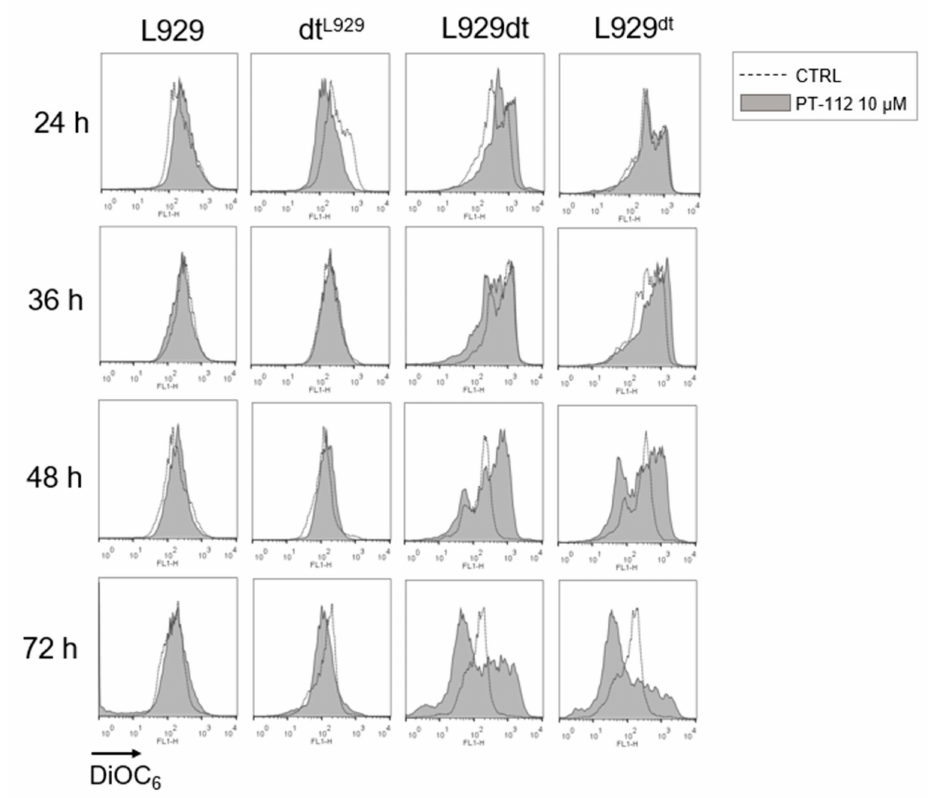
Figure 5. Analysis of mitochondrial membrane potential ( ∆Ψ m) upon treatment with PT-112 at different incubation times. A total of 3 × 10 4 cells were incubated with 10 µ M of PT-112 for 24, 36, 48 and 72 h at 37 ◦ C. Changes in ∆Ψ m were determined by staining with DiOC 6 and analyzed by flow cytometry. As shown in the legend, dotted histograms correspond to fluorescence values of untreated cells, and grey-colored histograms correspond to those of treated